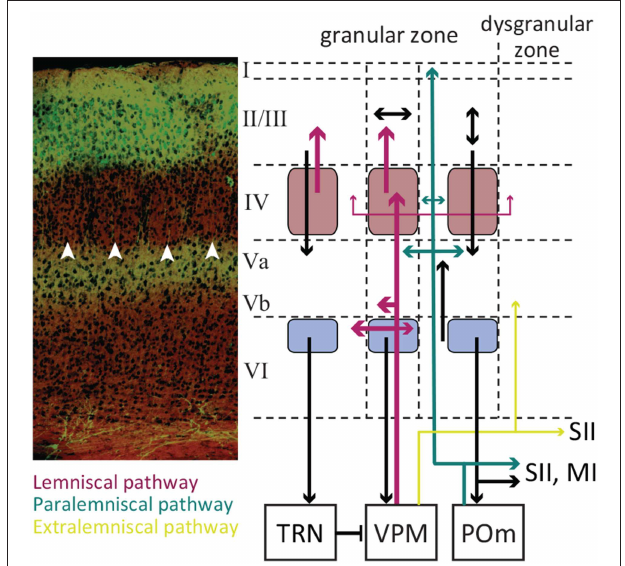
FIGURE 2 | The laminar organization of SI. A coronal section of the somatosensory cortex with cresyl violet Nissl Staining (left panel). The white arrowheads indicate barrels in layer IV. Excitatory neurons in layer II/III are GFP labeled with their terminals in Layer Va. The laminar pathway containing glutamatergic excitatory projections from VPM to layer IV and sparsely to layers Vb and VI (labeled red). The paralaminar pathway containing the projections from POm to layer Va and I (labeled cyan). The pink boxes represent the barrels, and the light purple boxes represent infrabarrels. Adopted from Petersen (2007) and modified. Immunohistology and confocal microscopy image by Ehsan Kheradpezouh and Mehdi Adibi.